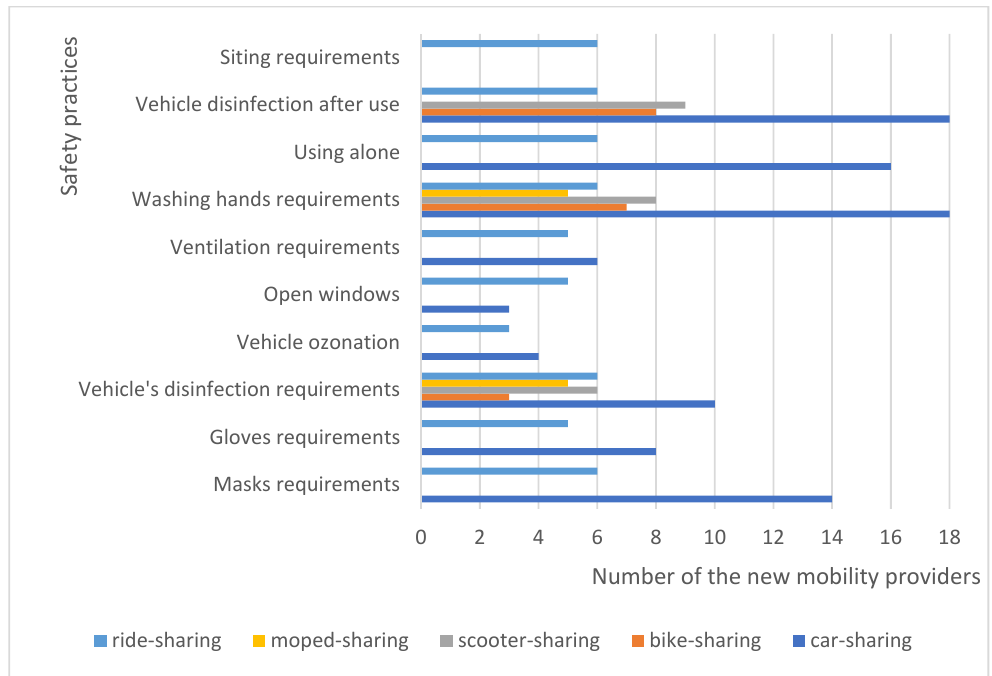
Figure 6. Safety practices from the new mobility providers’ point of view—detailed results broken down into new mobility sectors.